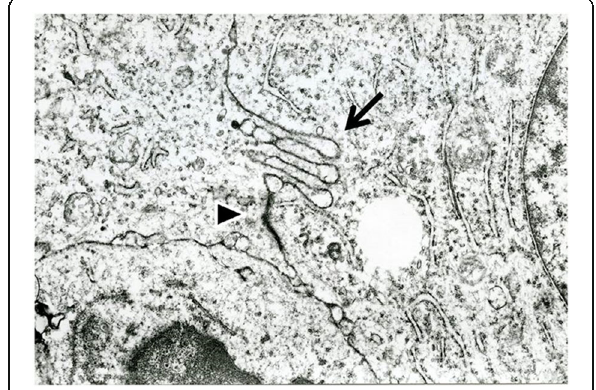
Fig. 4 Electron microscopy analysis of primary cytokeratin-positive interstitial reticulum cell (CIRC) tumor cells. A few interdigitating cell processes were observed (arrow). Some tumor cells had desmosome-like junctions (arrowhead). Of note, the tumor cells had no endocrine granules. Original magnification, ×